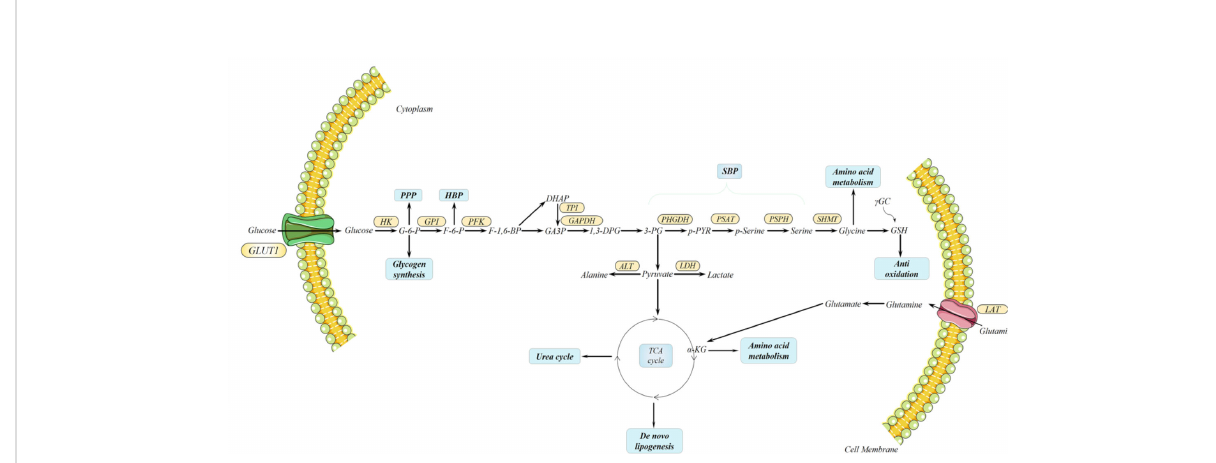
FIGURE 3 Metabolic rearrangements in pancreatic ductal adenocarcinoma (PDAC). In both primary and metastatic PDAC, metabolic rearrangements render PDAC extraordinary plasticity for the metabolites deprived. Among these rearrangements, mitochondrial respiration uni fi es several important bioenergetics; it produces precursors for lipid, amino acid, and nucleotide biosynthesizing and contributing to glutamine